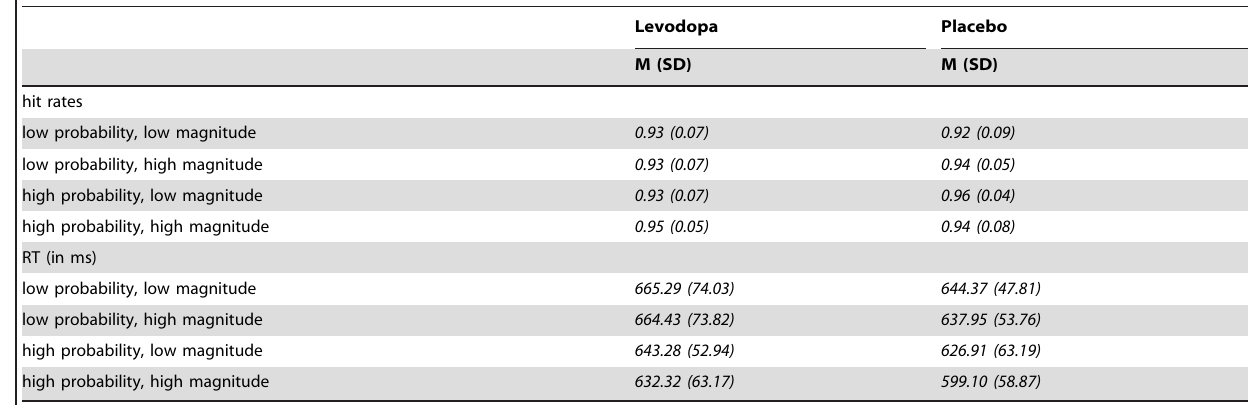
Table 1. Behavioral results anticipation.